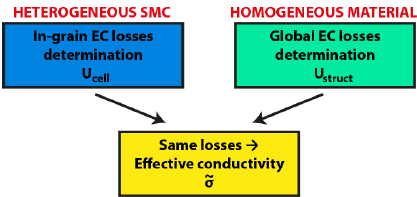
Figure 4: Homogenization strategy to keep consistency for the evaluation of losses.